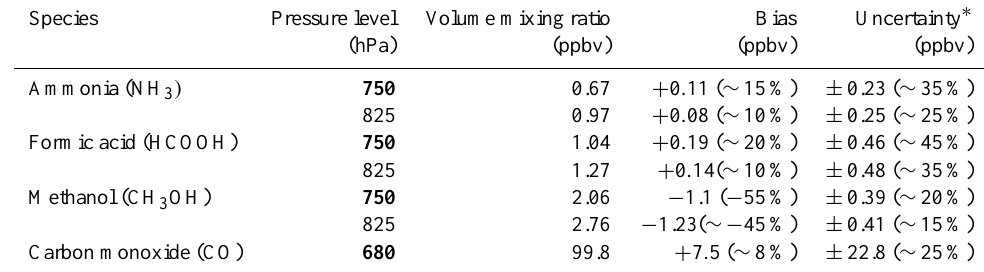
Table 3. TES/aircraft comparison statistics (actual errors) at peak satellite sensitivity level during JOSM. Species